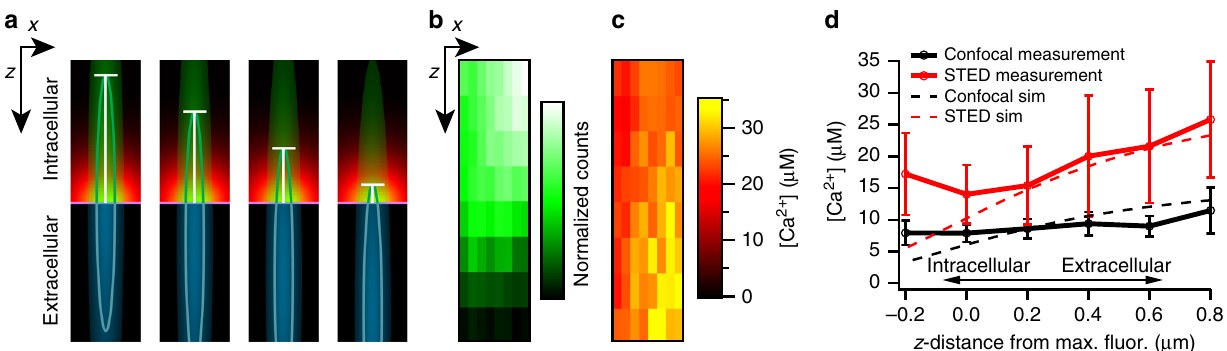
Fig. 9 Decreasing the focal volume of Ca 2+ imaging by moving the PSF in z . a Schematic drawing illustrating the decreased volume of intracellular dye that is sampled when moving the focus of the microscope down below the membrane in an xz -scan. Green lines indicate the FWHM of the PSF. b Representative data from an 8 × 8 pixel raster scan in x (50nm steps) and z (200 nm steps) of a hotspot of Ca 2+ -in fl ux-evoked OGB-5N fl uorescence at the AZ, depicting the rise in fl uorescence during depolarization. c The corresponding Ca 2+ concentrations calculated from the lifetime data of the recording shown in b . Notice the increase in [Ca 2+ ] toward the bottom of the plot. d Average maximum Ca 2+ concentrations ( “ scaled lifetime ratios ” ) calculated from the fl uorescence lifetime data of recordings acquired using both confocal imaging (black circles, n = 10 AZs, N = 10 IHCs) and STED imaging (red circles, n = 13 AZs, N = 13 IHCs), overlaid on top of the modeling data (from the model shown in Fig. 5) convolved with a 243nm ×243nm ×542nm Gaussian “ PSF ” ( “ confocal ” , black dotted line) or a 64nm ×64nm × 542 nm Gaussian “ PSF ” ( “ STED ” , red dotted line). Experimental data have been aligned in z relative to the maximal fl uorescence intensity as estimated from a 1D Gaussian fi t to the average fl uorescence per z -line during stimulation and binned in 200-nm z